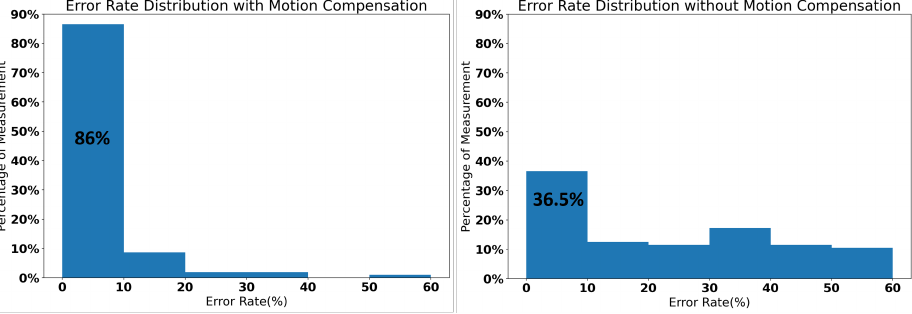
Figure 9. HR measurement error rates when participants sit in a parked vehicle with motion compen- sation ( left ) and without motion compensation ( right ).